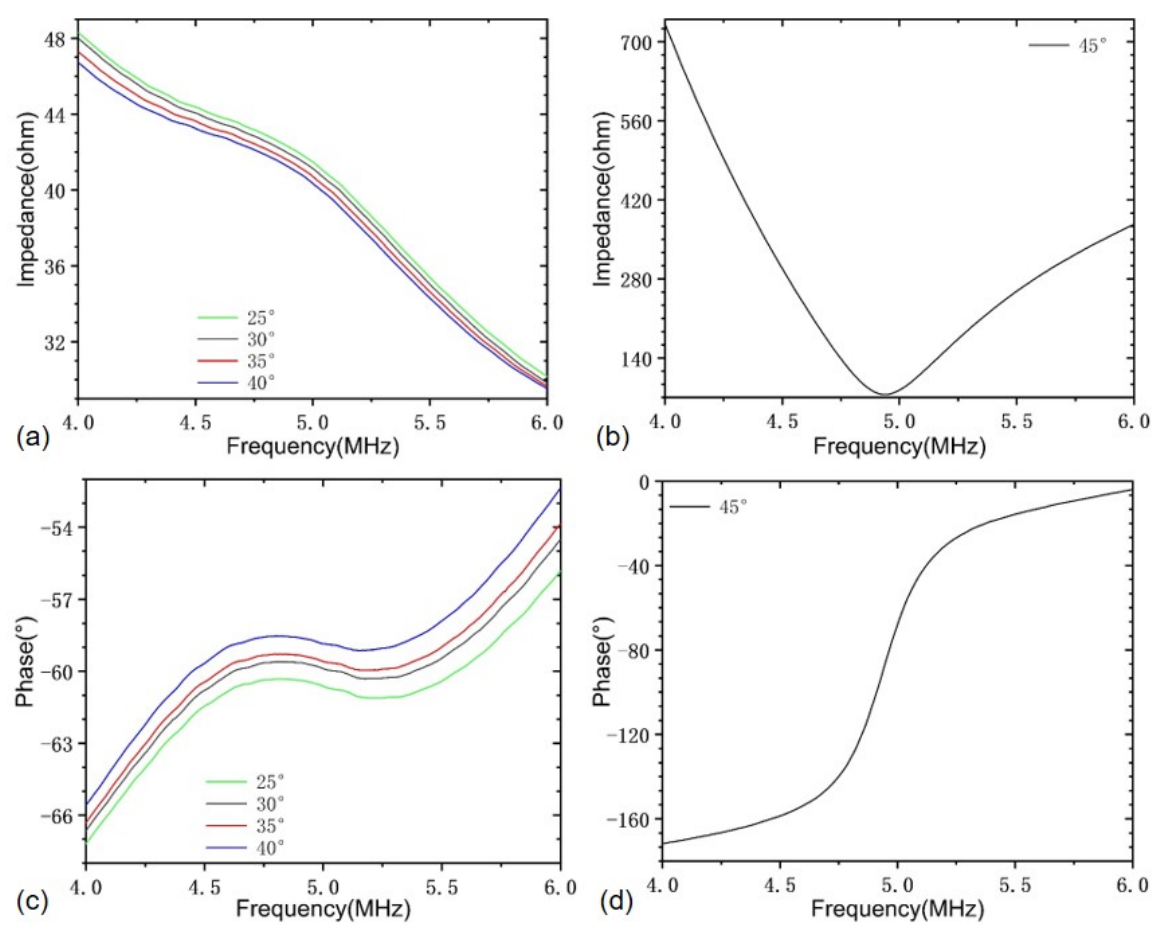
Figure 7. Impedance and phase spectra at different temperatures: ( a , b ) impedance and phase spectra in the temperature range from 25 to 40 °C; ( c , d ) impedance and phase spectra at 45 °C.